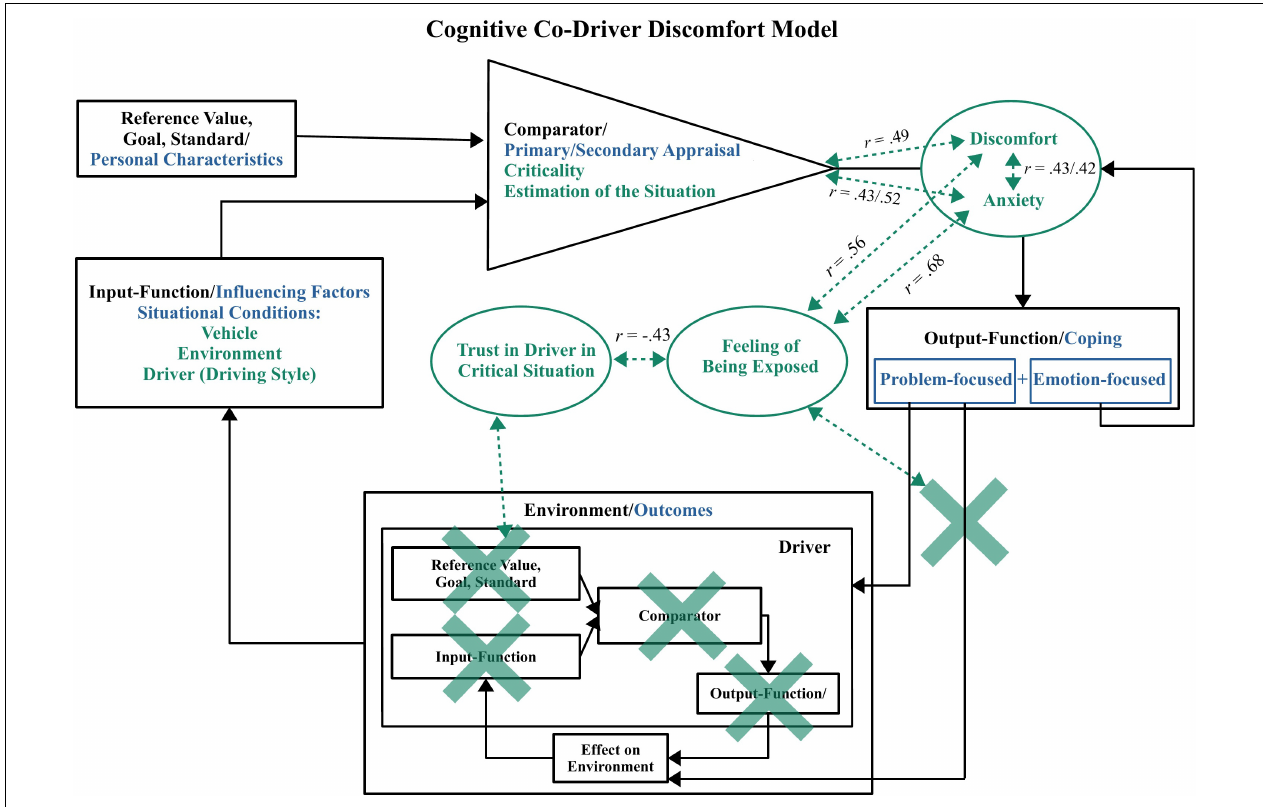
FIGURE 5 | Co-Driver Discomfort Model describing the development of co-driver discomfort considering limited information about the cognitive state of the driver and limited control over the situation. Elements of the transactional model that are adapted from Lazarus and Folkman (1984) are marked in blue. The elements and causal connections of the feedback-loop model adapted from Carver and Scheier (1998) are shown in black. Additional components and respective correlations found in the interview and questionnaire are drawn in green with dashed arrows. Aspects that are not available or have limited accessibility to a co-driver are crossed